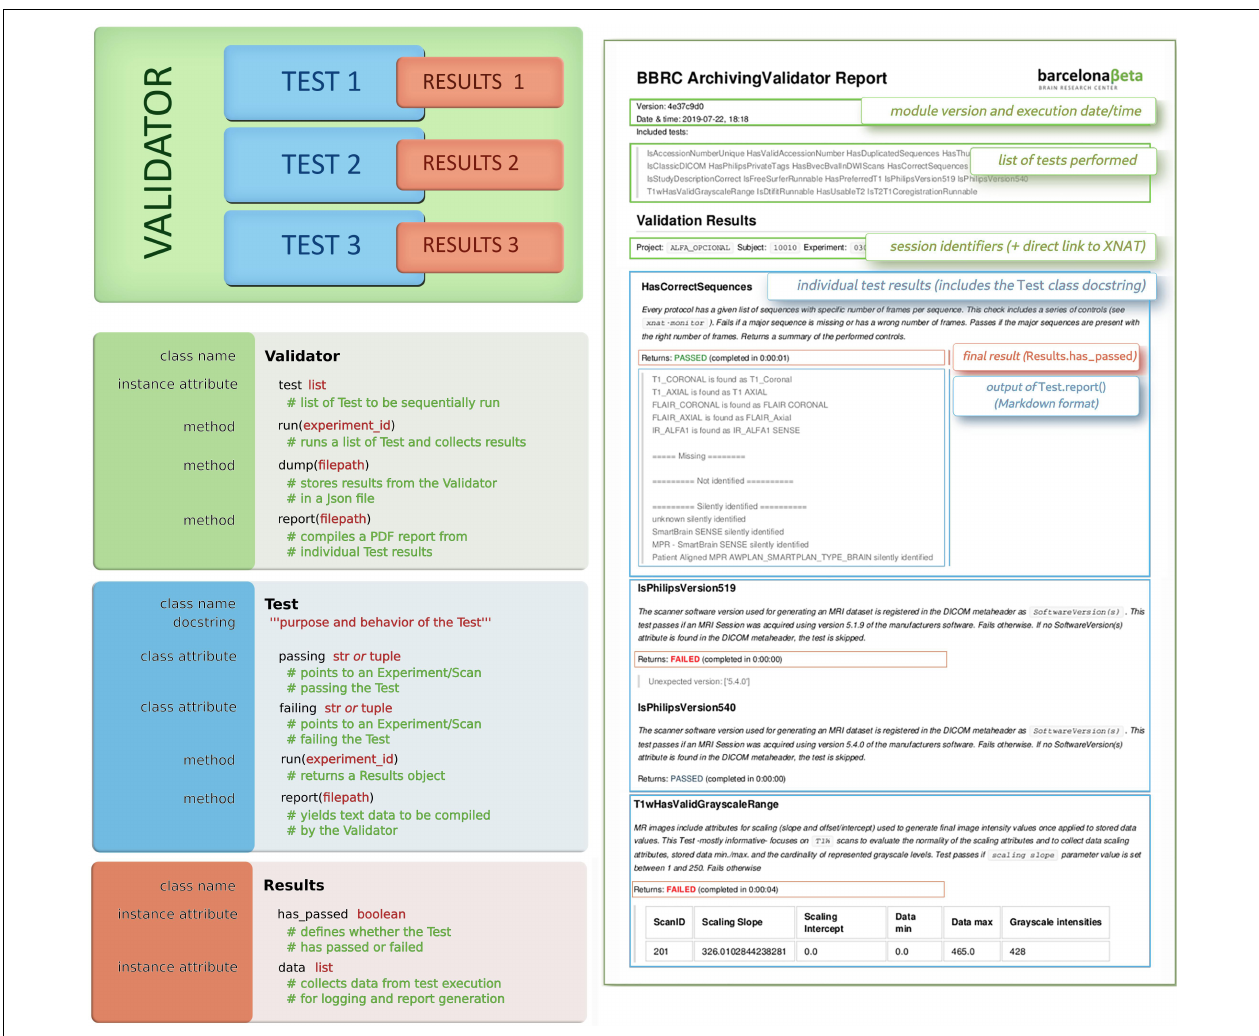
FIGURE 3 | (Left) Validators : concepts and classes. Validators and Tests all share the same template. Validators are defined by a list of Tests , which in turn yield some Results . Each Results object embeds a main Boolean, which defines whether the Test was successful, and some additional data for logging purposes or report generation. (Right) Example of a produced validation report (only the first page is displayed); the color code highlights the matching between sections of the report and the corresponding concepts: green refers to Validators , each blue area corresponds to a Test , and Results are shown in red